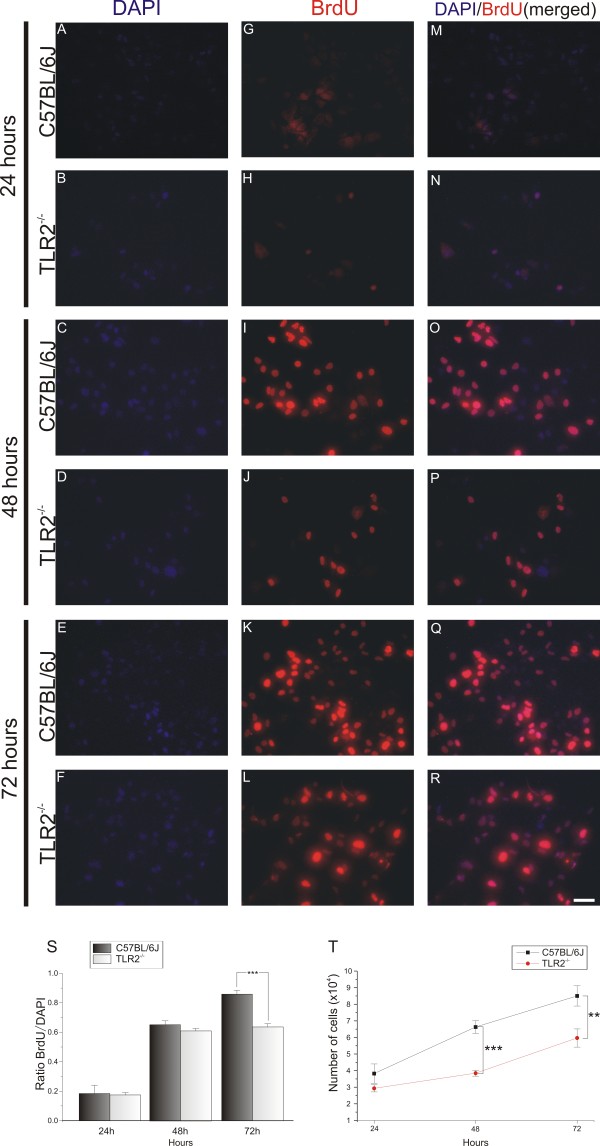
Cell proliferation assay in purified astrocyte cultures from C57BL/6J wild-type (WT) and Toll-like receptor (TLR)2 knockout (KO) mice (TLR2−/−) mice. (A-R) 4′,6-diamidino-2-phenylindole (DAPI and 5-bromo-2′-deoxyuridine (BrdU) immunostaining after culturing for 3 days. (A-L) Single labeling with (A-F) DAPI And (G-L) BrdU. (M-R) Double labeling with DAPI and BrdU; note the greater amount of nuclear staining in WT-derived cultures. (S) Graph showing the ratio of BrdU:DAPI; note that WT cell cultures displayed a greater proliferation rate, especially at 72 hours. (T) Graph showing the astrocyte number for each day; the absence of TLR2 affected the cell growth after 48 hours. ** P<0.01; *** P<0.001. Scale bar:50 Î¼m.